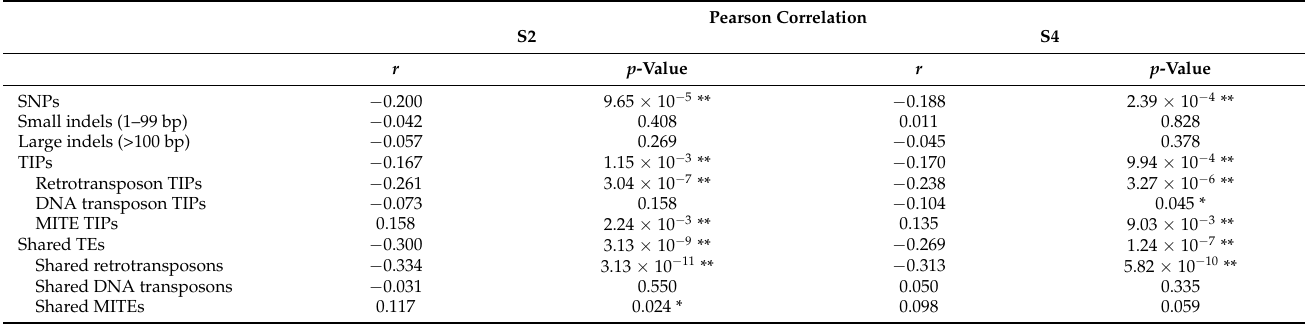
Table 1. Correlation between local HE frequency and SNPs, indels, TIPs, and shared TEs.